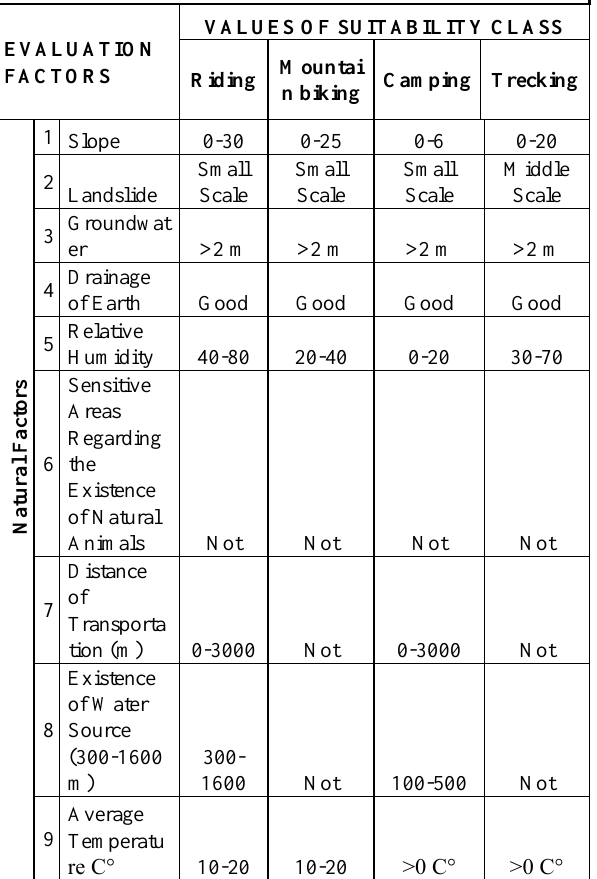
Table 1. Evaluation Factors of the Activity of Tourism